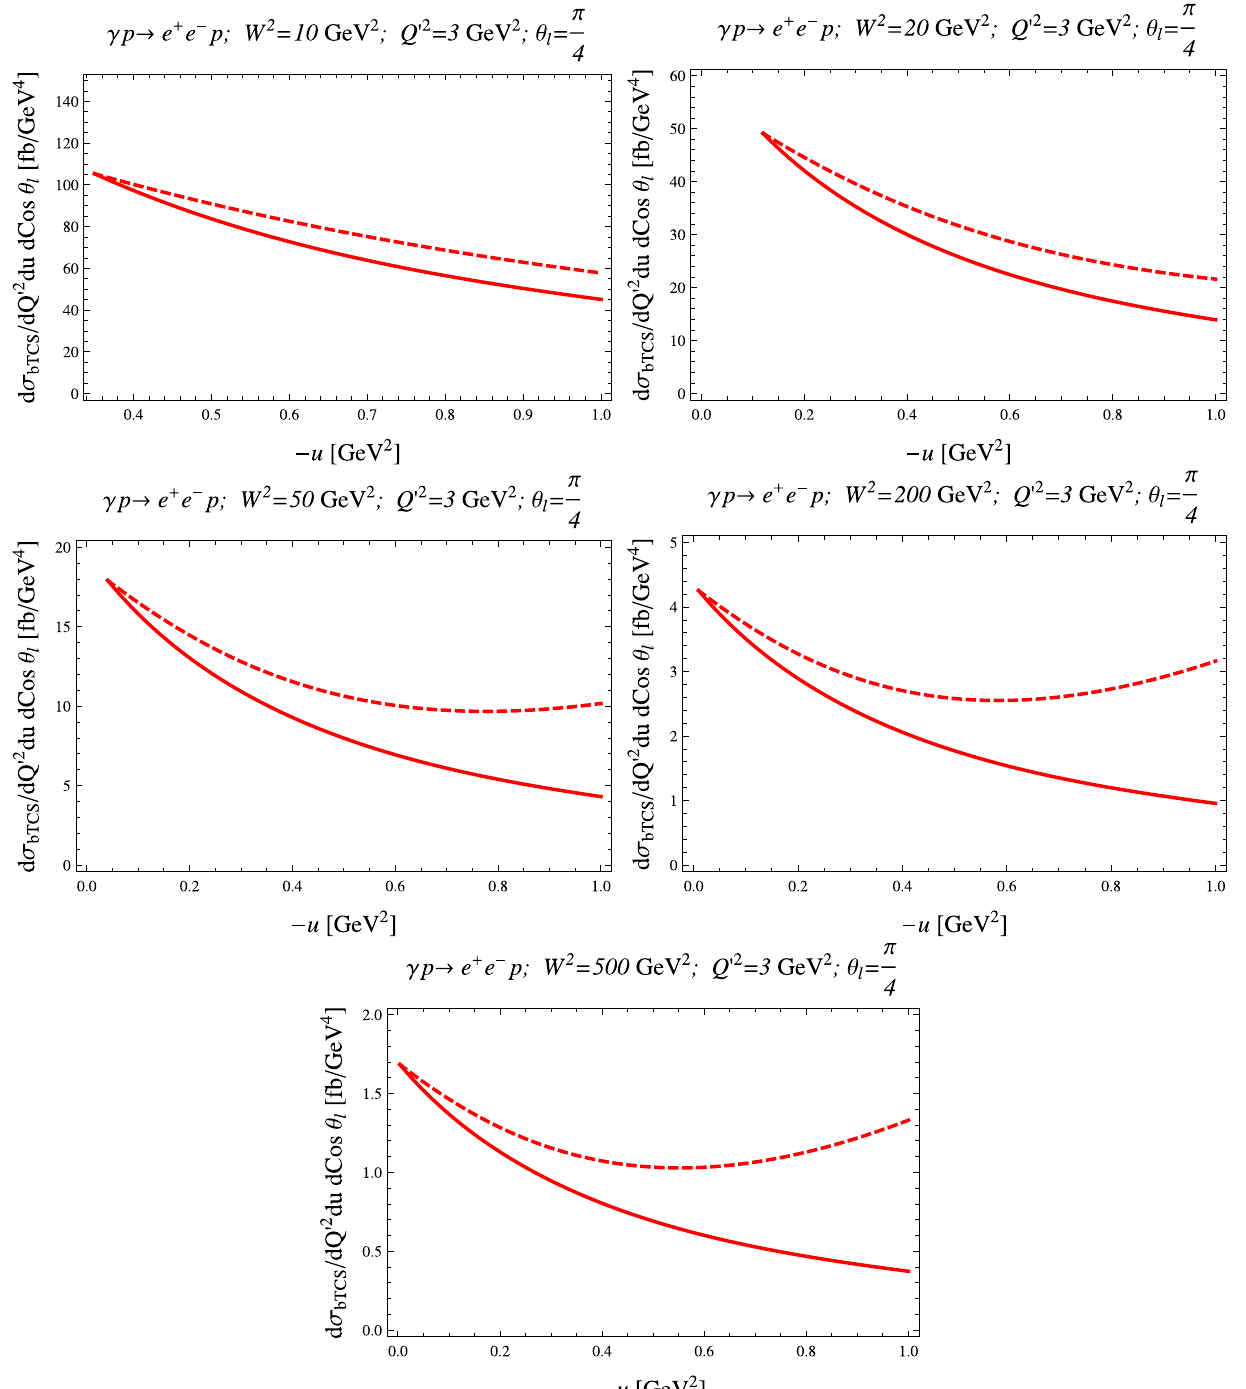
Fig. 8 The near-backward γ p → pe + e − scattering cross section (32) for several values of W 2 ; Q (cid:4) 2 = 3 GeV 2 ; and lepton polar angle θ (cid:6) = π as a function of − u from the minimal value − u 0 4 up to 1 GeV 2 . COZ solution is employed as input phenomenolog-